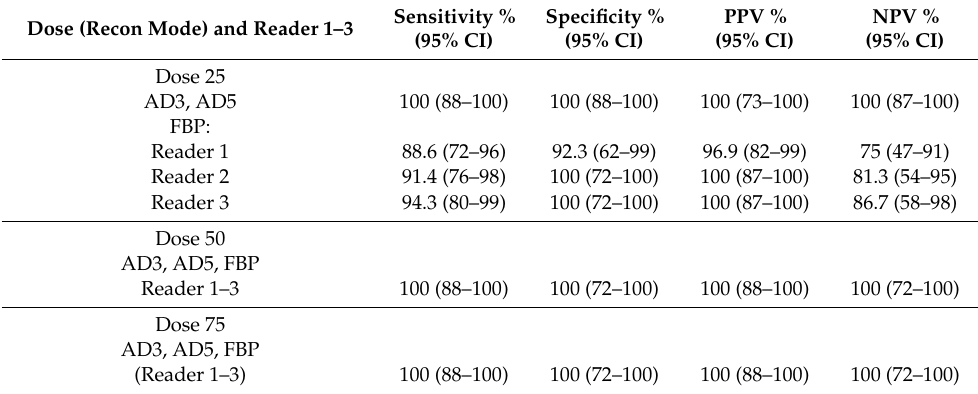
Table 3. Diagnostic accuracy of low-dose computed tomography (LDCT) datasets for the detection of cervical